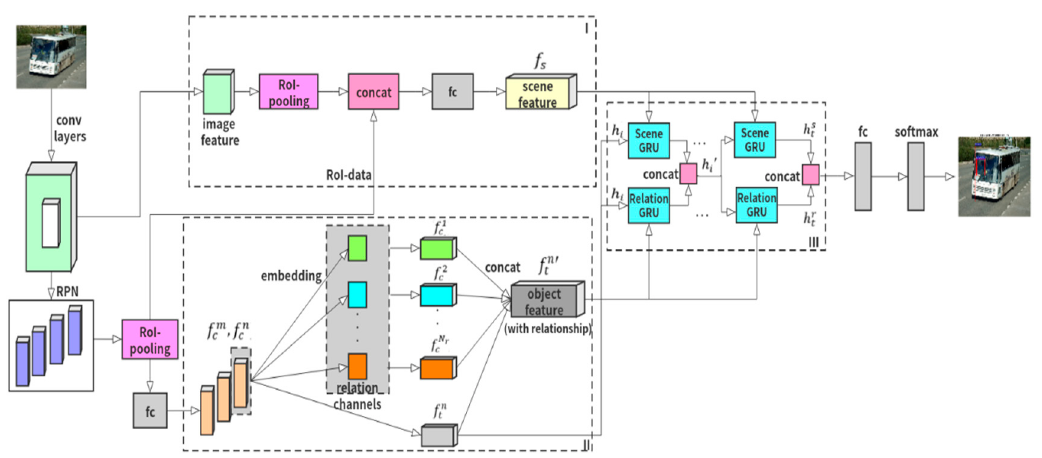
Figure1. Theframeworkofourapproach. I:Scene-levelinformationprocessingmodule. II:Relationship Figure 1. The framework of our approach. I: Scene-level information processing module. II: module. III: Message passing Relationship module. III: Message passing module.